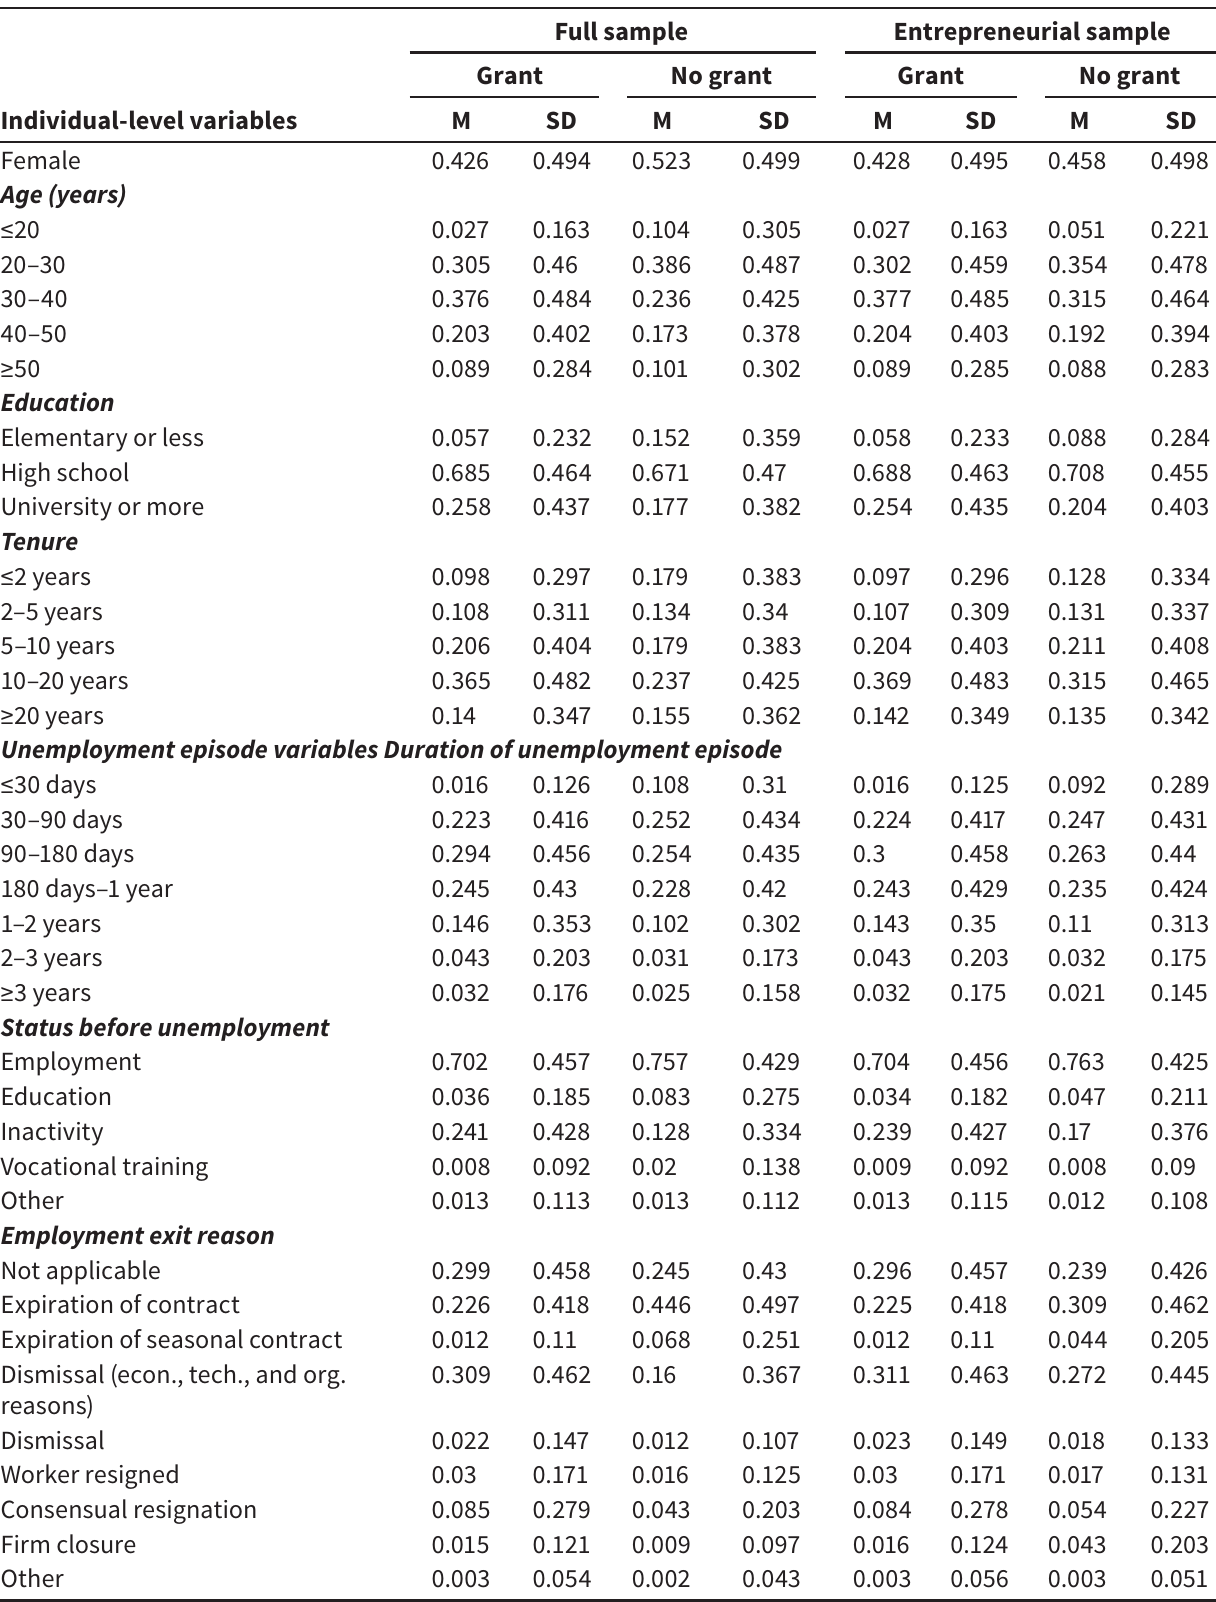
Descriptive statistics of unemployment spells which ended in